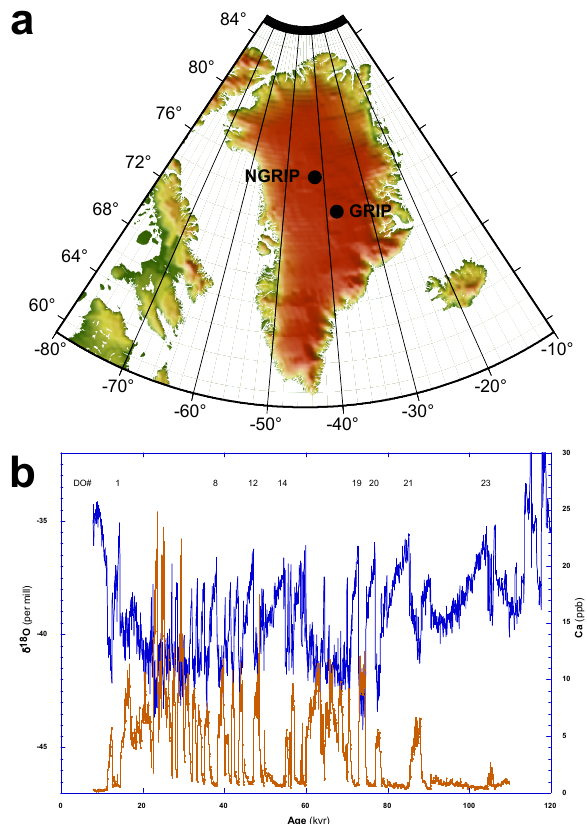
Fig. 1. Greenland ice cores discussed in the text. (a) Location of the GRIP and NGRIP Greenland ice cores. (b) Variation of the δ 18 O (blue curve) and of the dust concentration (red curve) during the last climate cycle in the GRIP ice core (Johnsen et al., 2001) show- ing the record of the abrupt warming named Dansgaard-Oeschger events associated with abrupt decreases of the dust